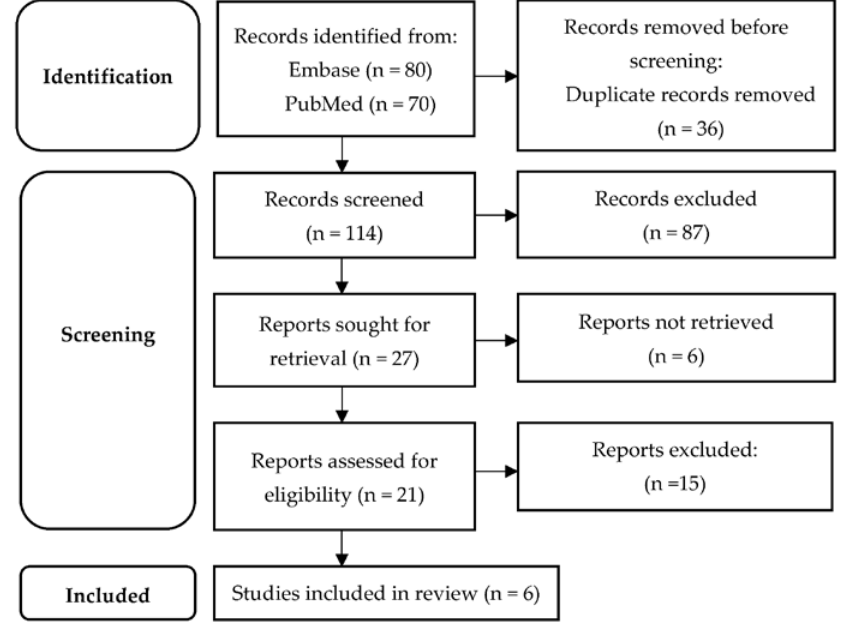
Figure 1. PRISMA diagram of the study selection process.